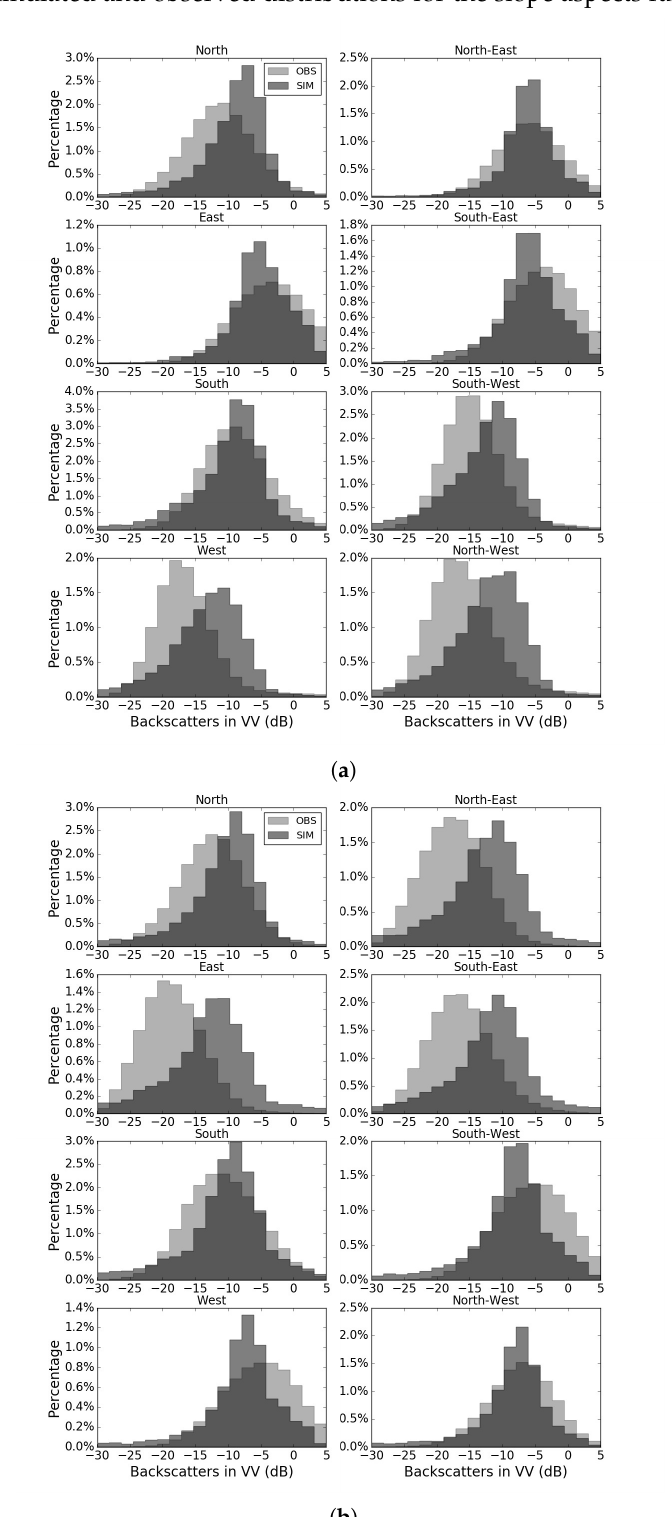
Figure 7. Distributions of backscatter values simulated and observed in VV polarization for the main slope aspects for two close dates (one for each orbit type): ( a ) 13 February 2017 (descending orbit); and ( b ) 14 February 2017 (ascending